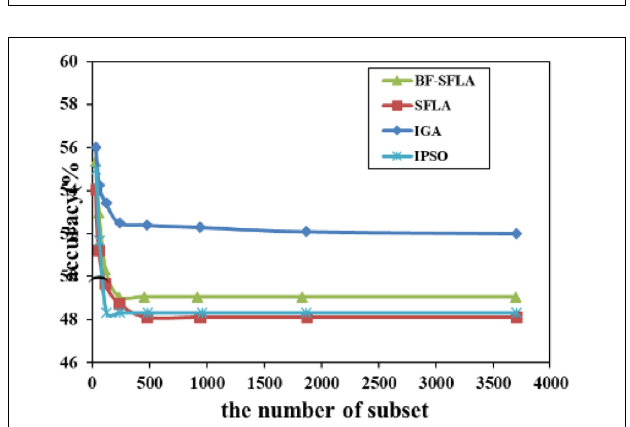
FIGURE 13 | The variation trend of classification accuracy and feature subset of DLBCL-NIH.